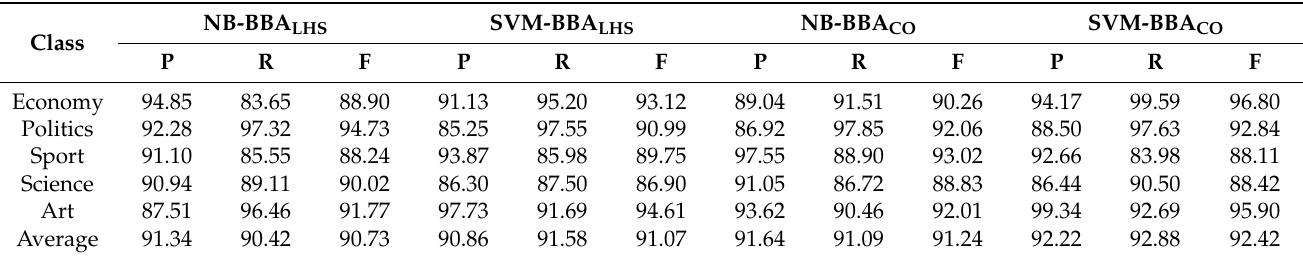
Table 23. Classification results of Al-Jazeera news dataset using NB and SVM in terms of precision (P), recall (R) and F-measure (F).